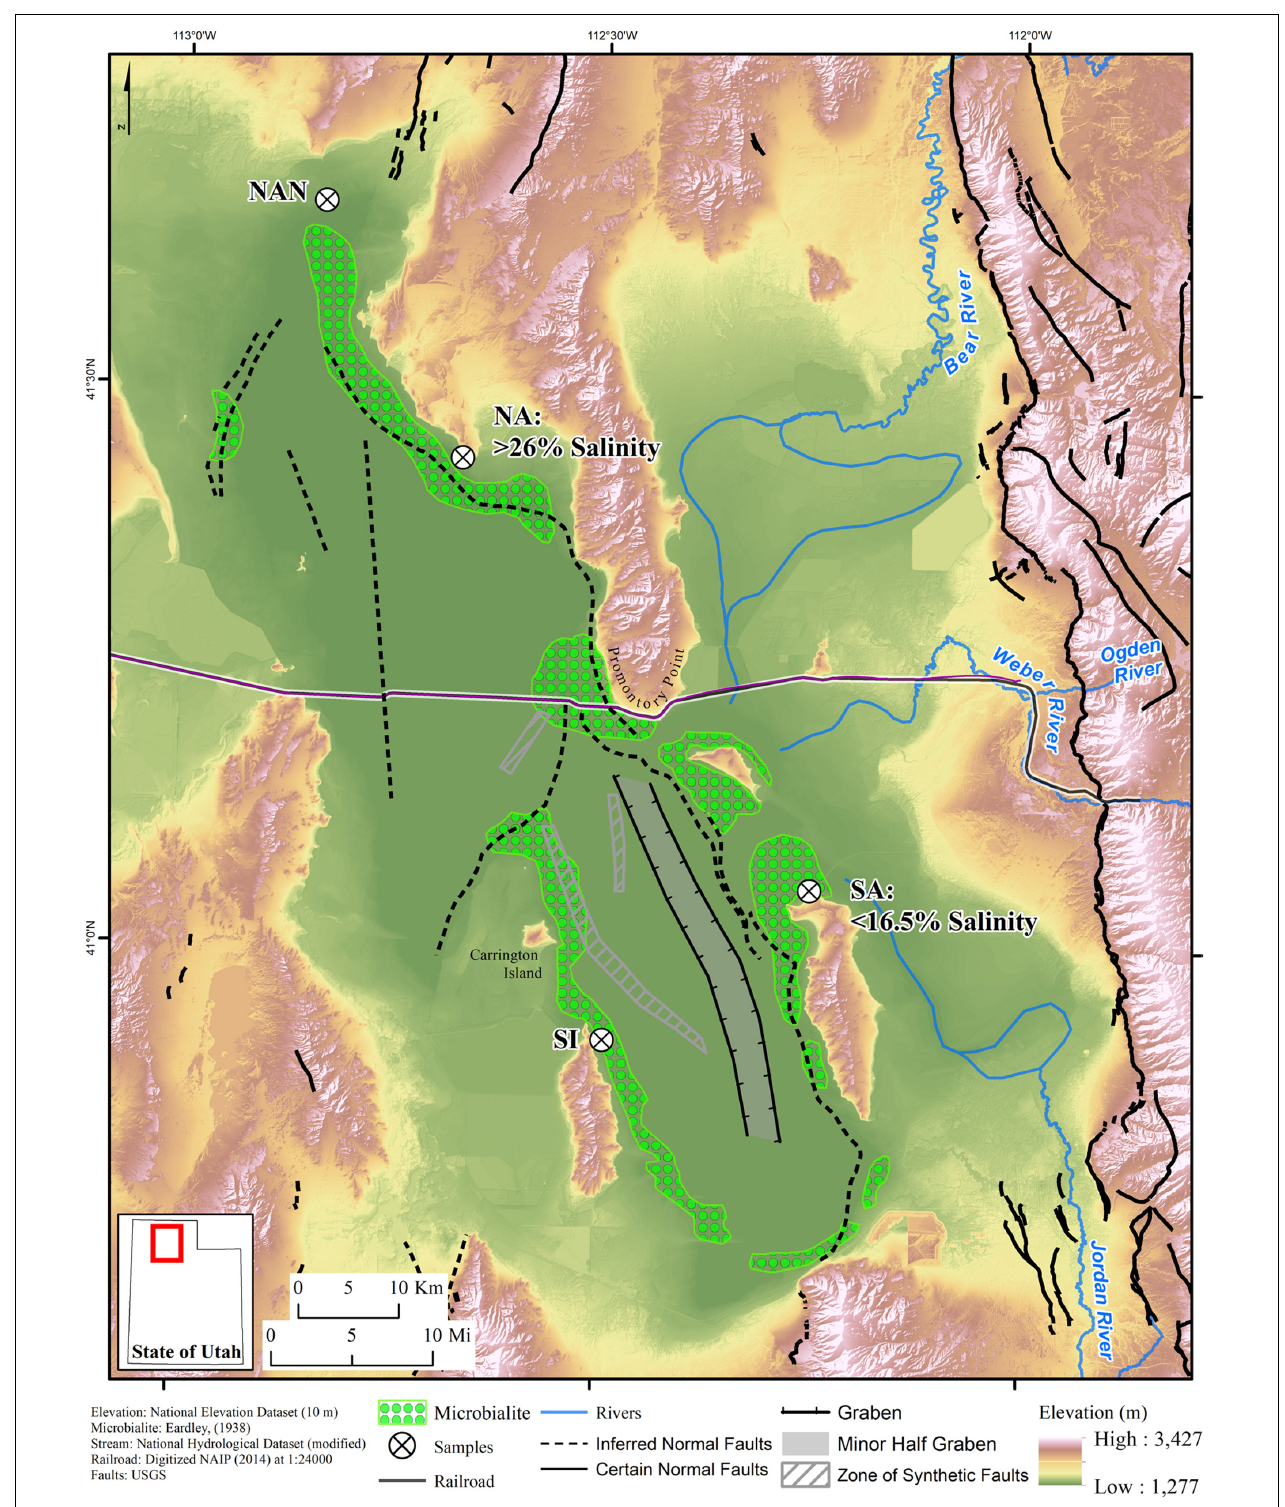
FIGURE 1 | Map of Great Salt Lake (GSL) with sampling locations indicated by white circles with crosses. The railroad causeway separating the North Arm (NA) from the South Arm (SA), typical NA and SA salinities, the primary rivers draining into GSL, and major faults (hatched areas and dashed lines) are indicated. The distribution of microbialites is depicted based on mapping conducted by Eardley (1938). Structure modified from Colman et al. (2002) and UGS Quaternary Fault and Fold Database (Survey, 2013). Abbreviations: NAN, North Arm north hand sample collection site; SI, Stansbury Island microbial mat sampling site.